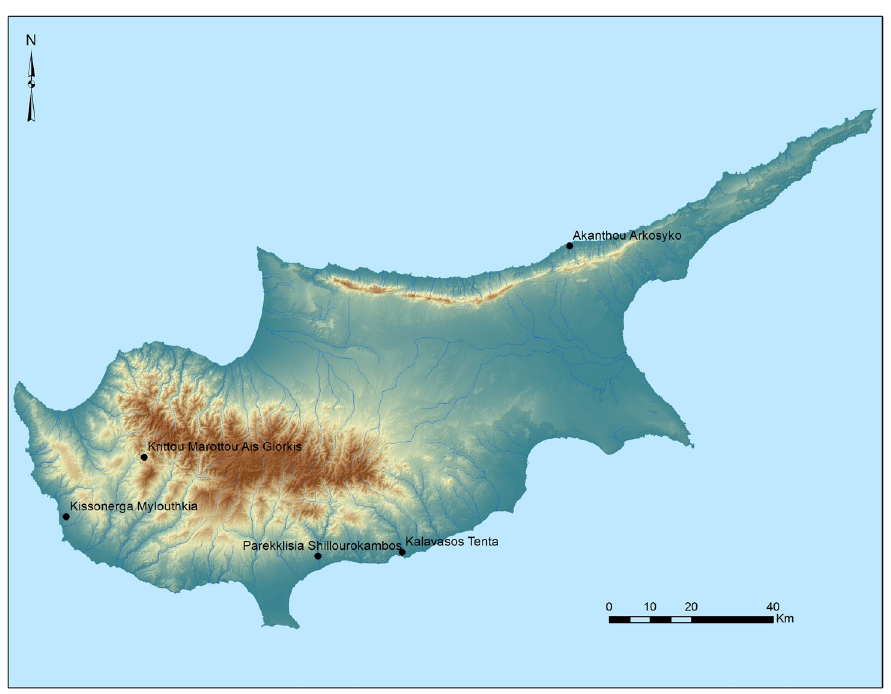
Figure 1. Map of Cyprus depicting the location of the Early Aceramic Neolithic sites with obsidian artefacts discussed in the text. Map generated by the